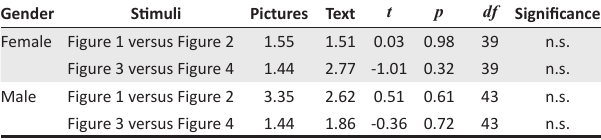
TABLE 5: Galvanic skin response results: A comparison of text versus picture responses per